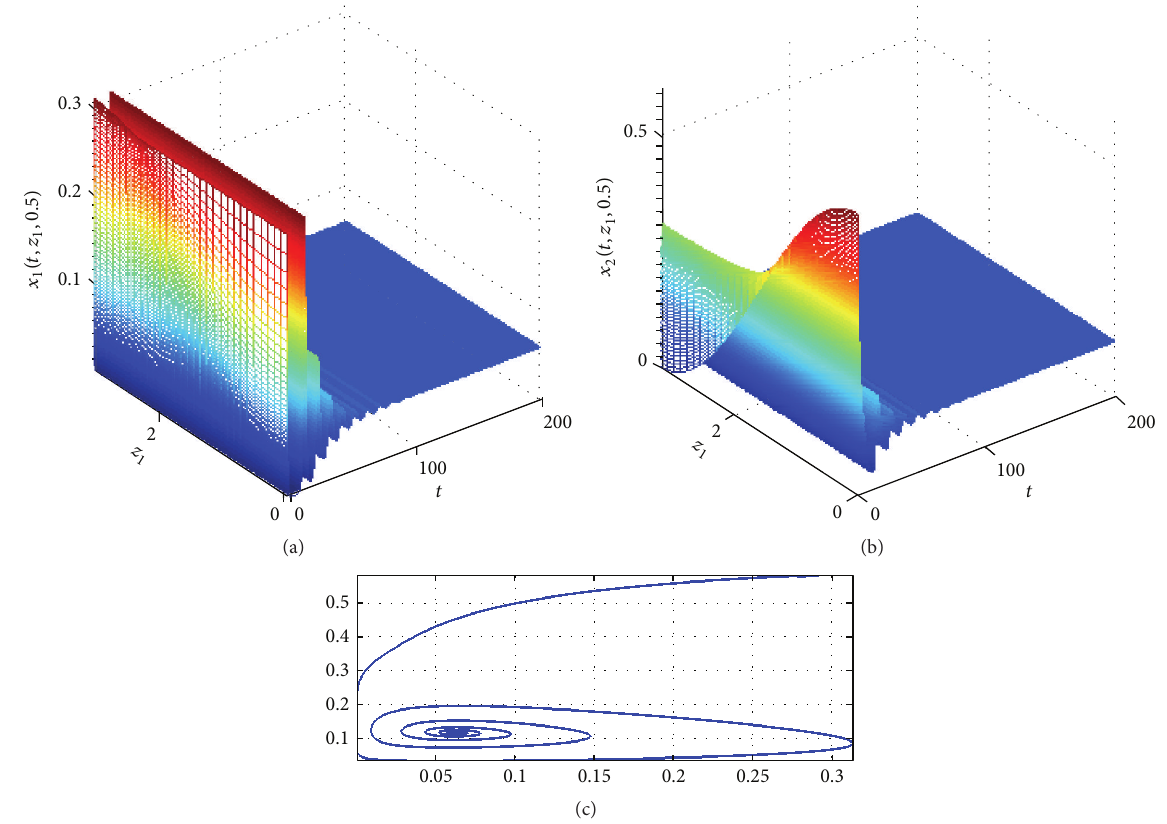
Figure2:Numericalresultsforthestateestimationanalysis.(a)Timespatialresponse 𝑥 1 (𝑡,𝑧 1 , 0.5) in (𝑡,𝑧 1 ) domain.(b)Timespatialresponse 𝑥